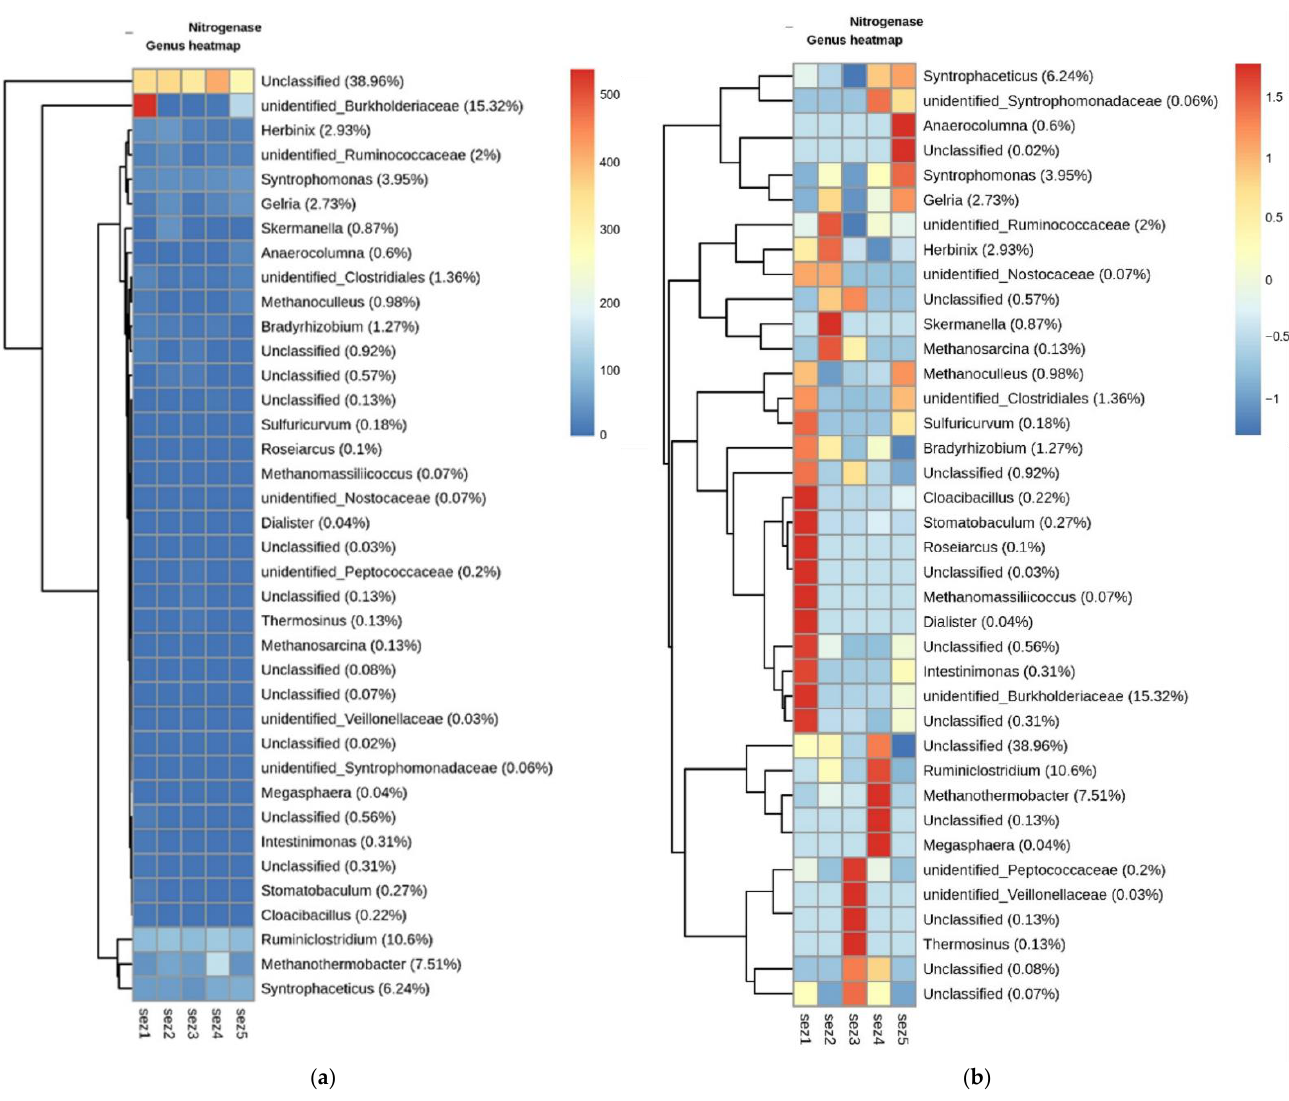
Table A1. The list of queried pathways.